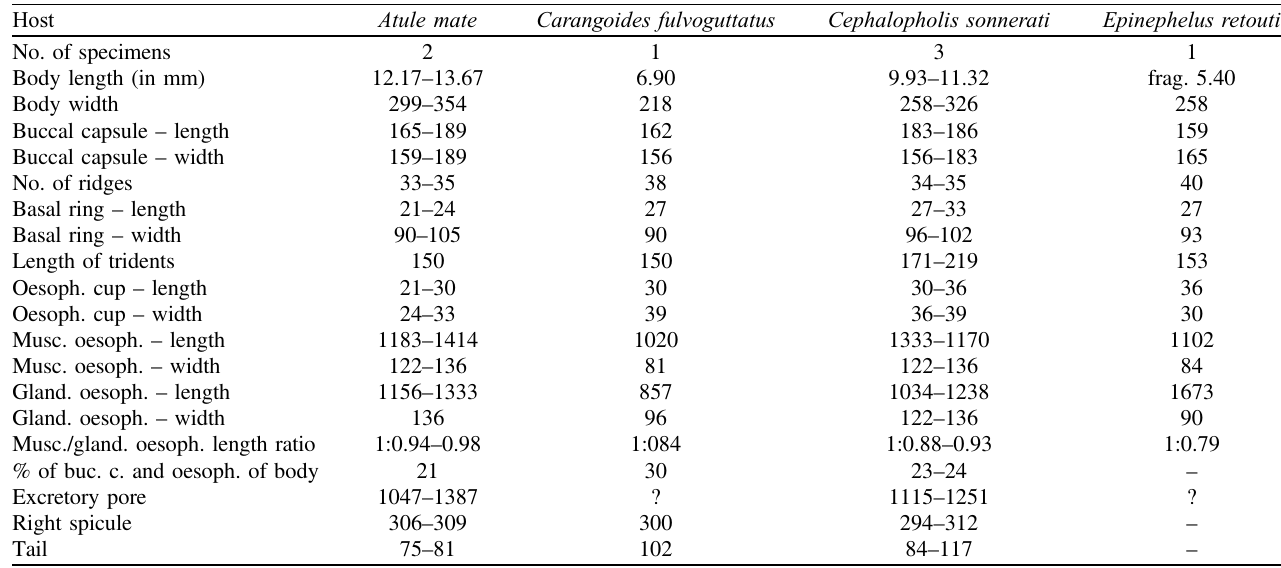
Table 1. Comparison of measurements of Camallanus carangis males from marine fi shes in New Caledonia.